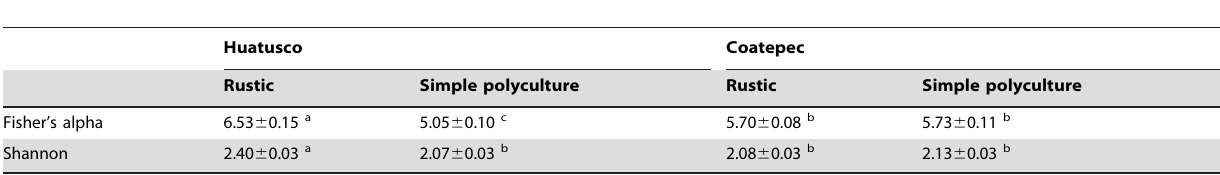
Table 4. Fisher’s alpha and Shannon’s diversity index of endophytic fungi in the four coffee plantations.